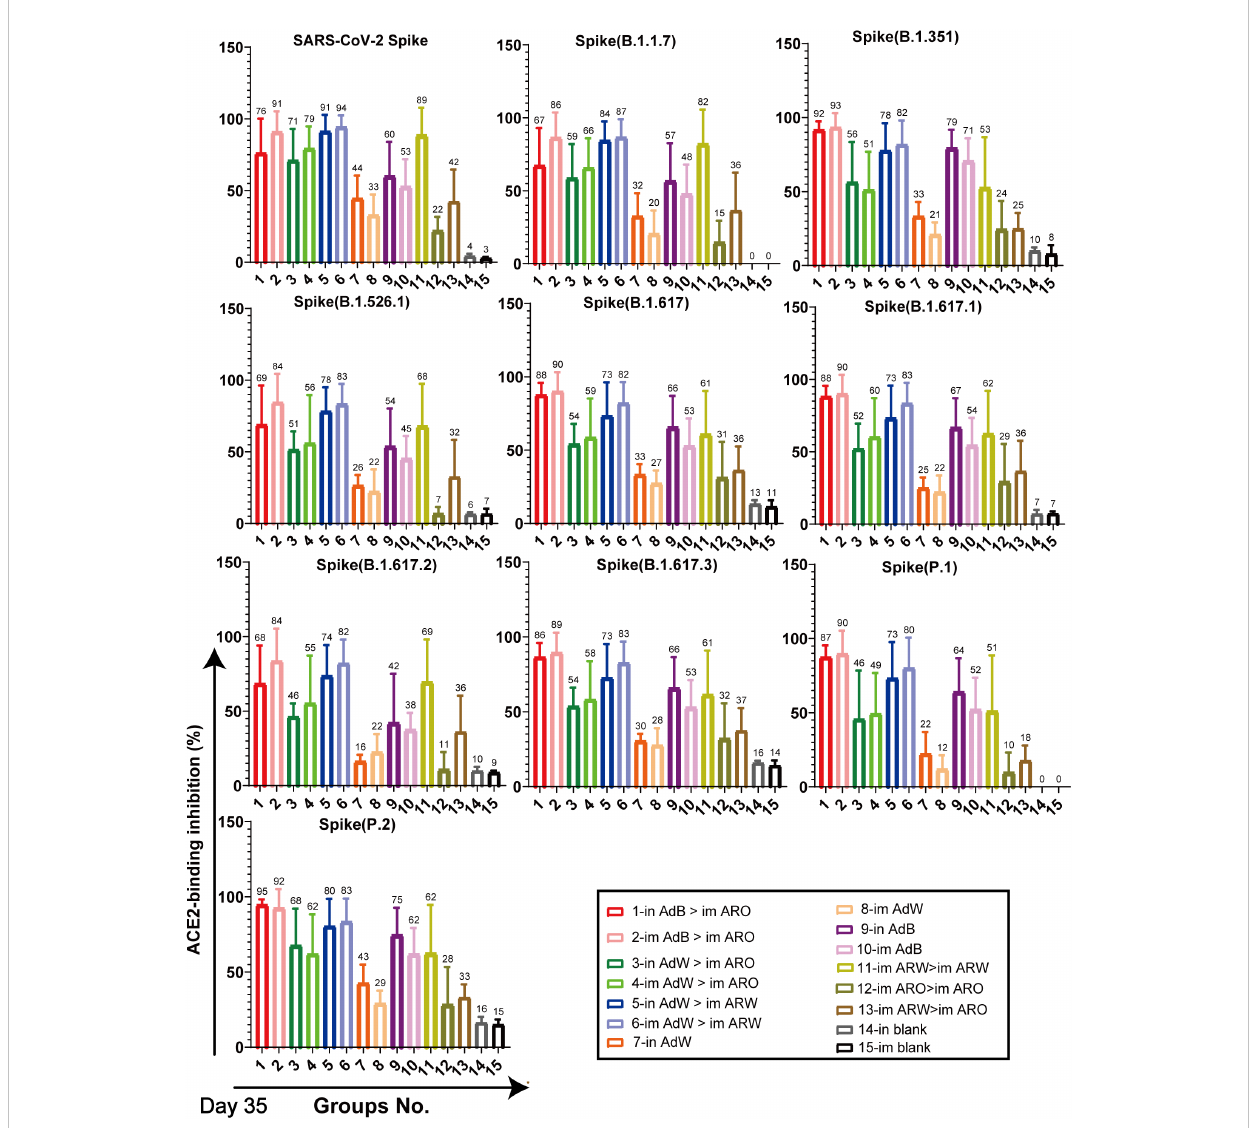
FIGURE 6 Neutralisation capacity of sera was observed by measuring the inhibition of binding between angiotensin-converting enzyme 2 (ACE2) and SARS- CoV-2 spike proteins on day 35 after primary immunisation. Spike proteins were from the SARS-CoV-2 prototype and B.1.1.7, B.1.351,